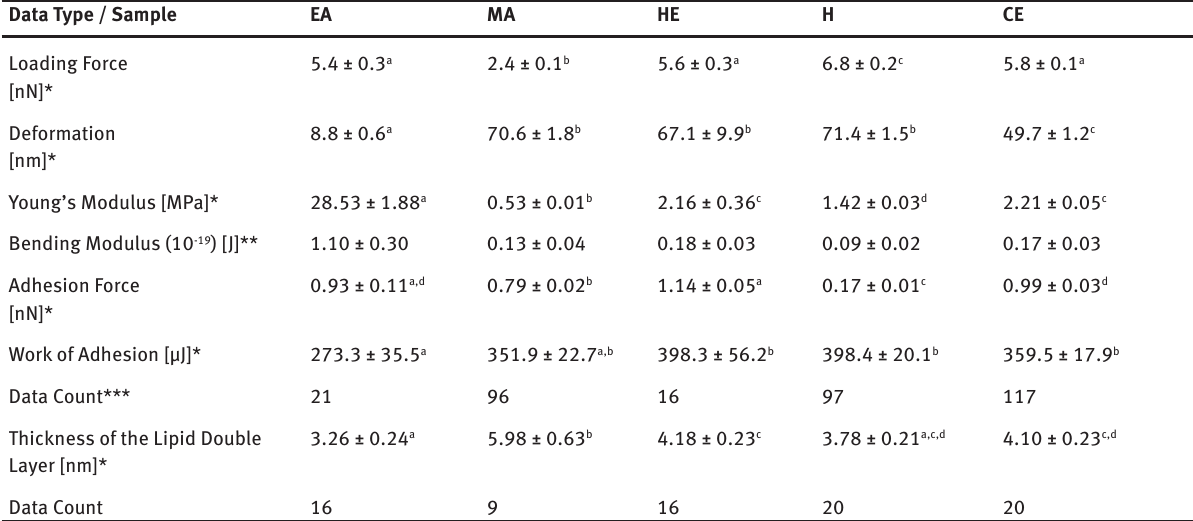
Table 3: Parameters obtained from the quantitative force curve analysis of SUV. Data Type /